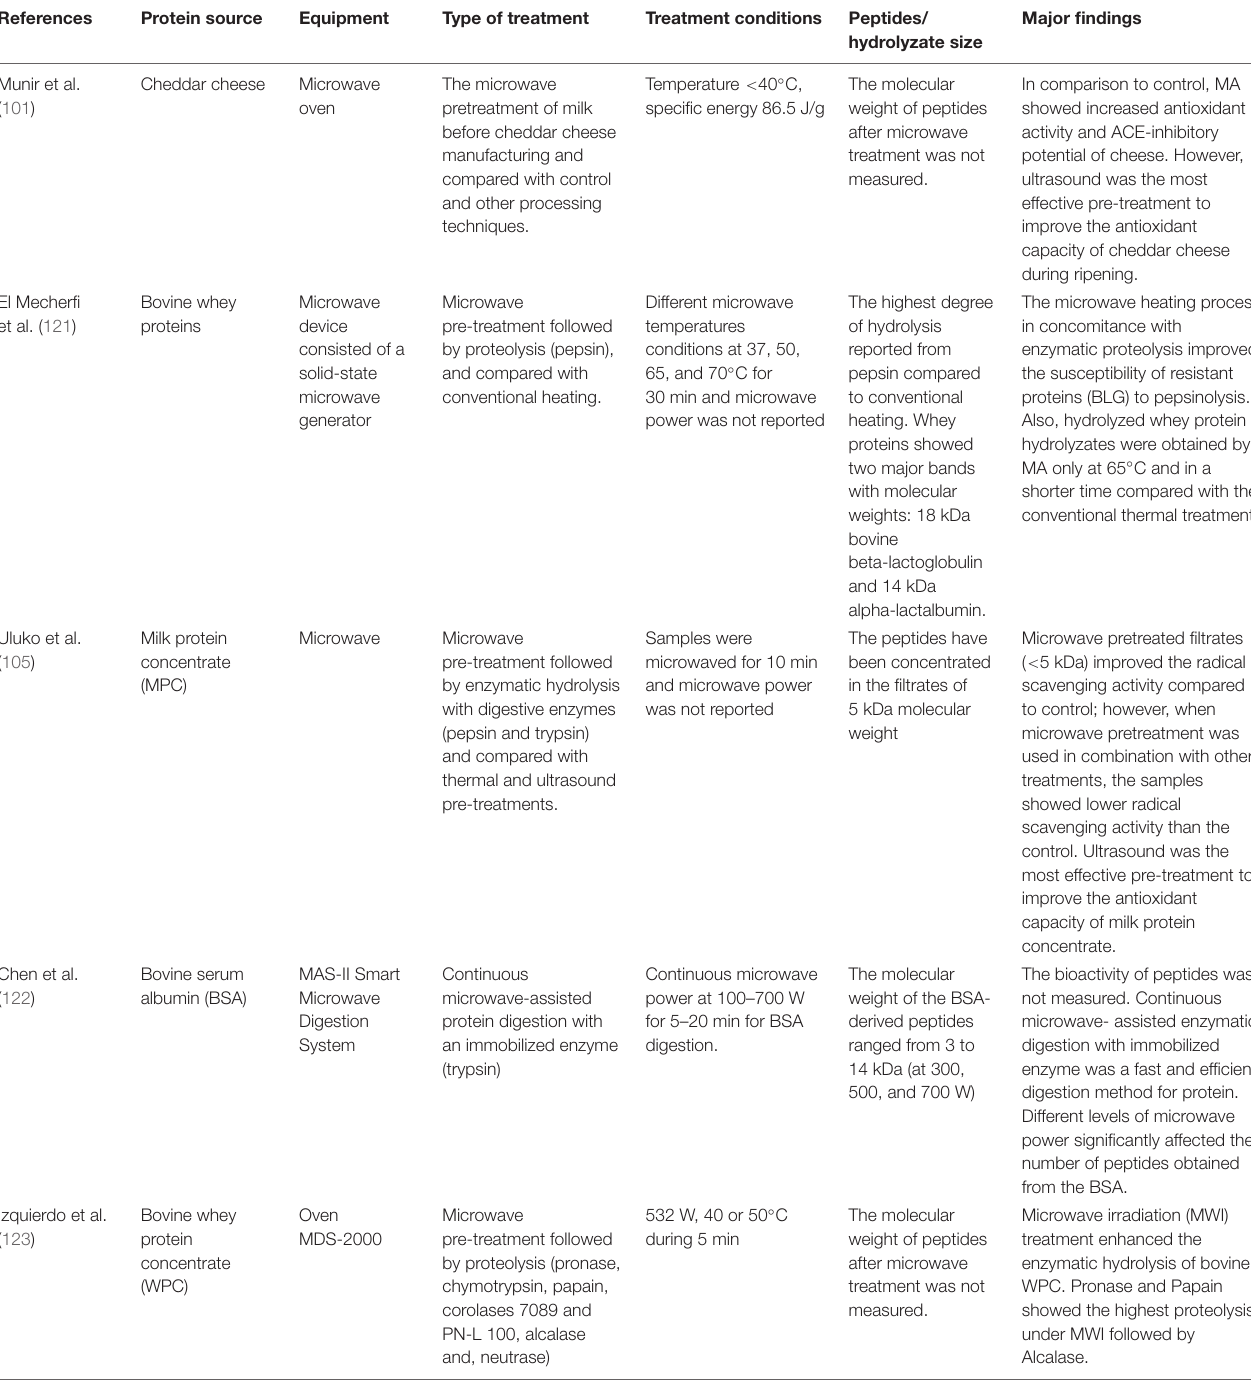
TABLE 4 | Applications of microwave-assisted processing for the production of bioactive